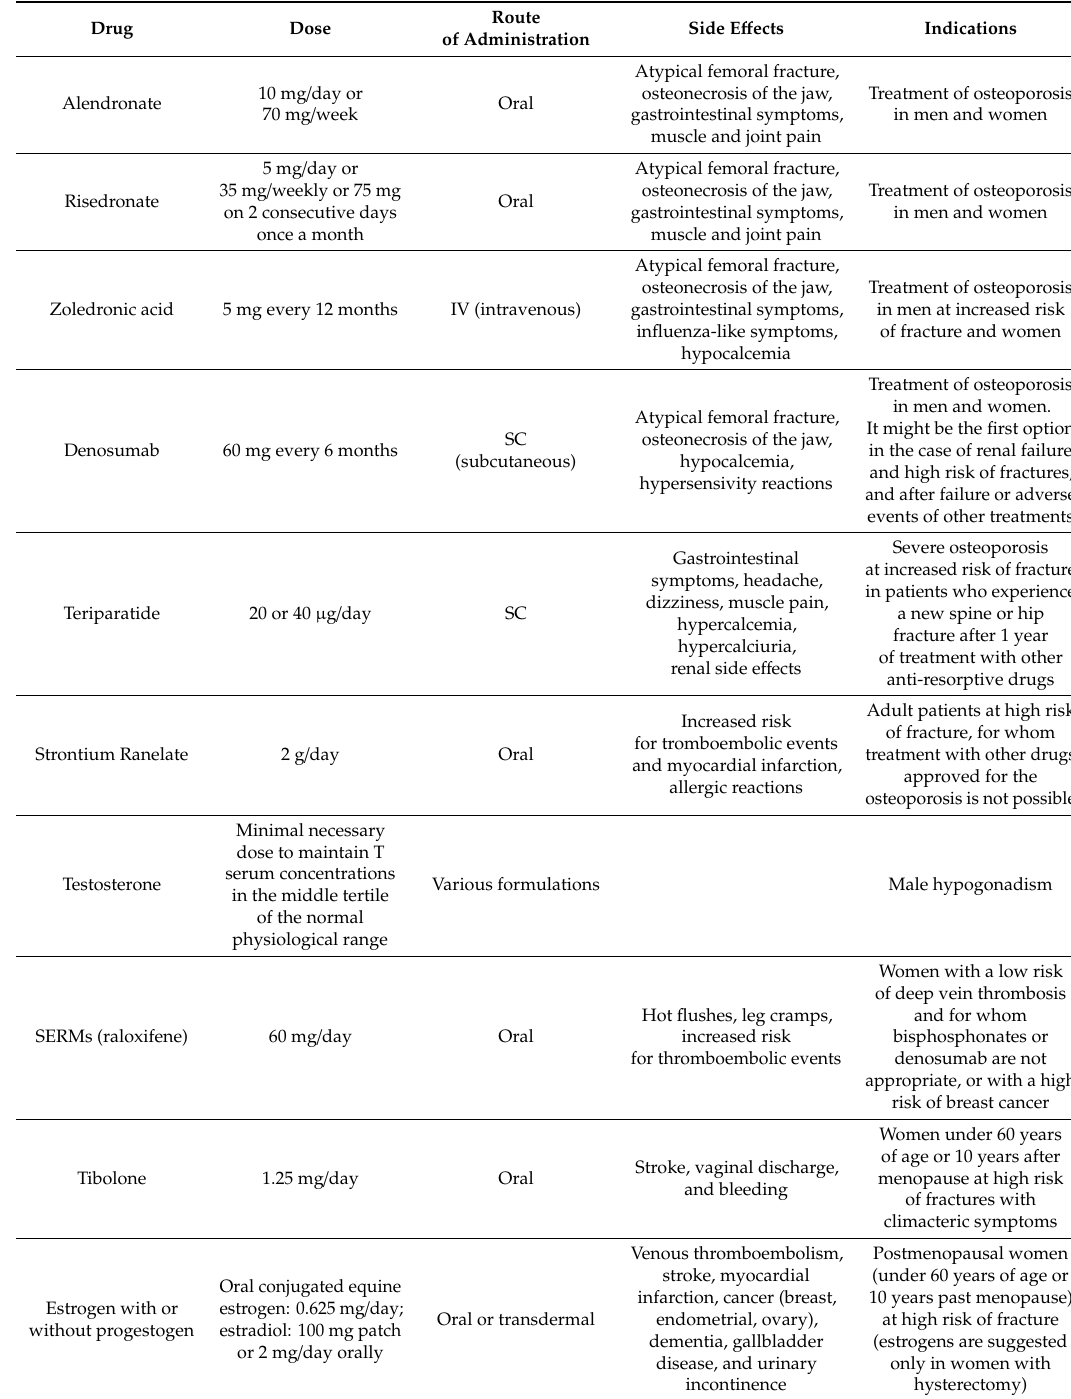
Table 3. Drugs for the treatment of